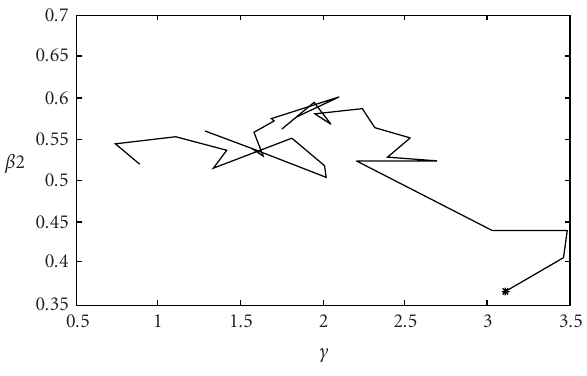
Figure 5: The relation between proportion γ and β 2 .